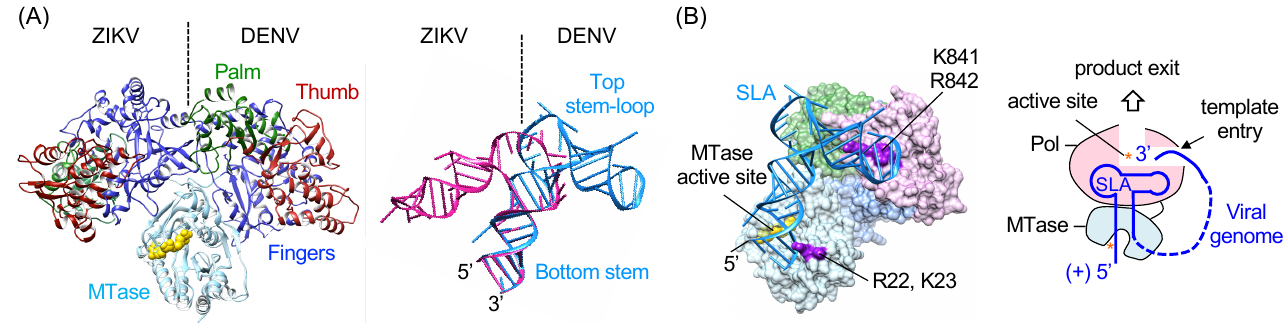
Figure 4. Model of the NS5-SLA complex. ( A ) Domain arrangements in flavivirus NS5 and stem-loop A (SLA). The structures of the flavivirus NS5 and SLA show different relative orientations of their domains. ZIKV and DENV NS5 structures are superposed by their MTase domains; domains are indicated only in DENV NS5 for clarity (left). The ZIKV and DENV SLA structures are superposed by their bottom stems, and the top stem-loop and bottom stem are indicated in DENV SLA (right). ( B ) Model of the NS5-SLA complex. The NS5-SLA complex is modeled based on the binding assays of mutant NS5 and previous biochemical assays. The schematic of SLA interaction with NS5 is shown on the right. The model suggests that flavivirus NS5 recognizes both the 5 (cid:48) end SLA and the 3 (cid:48) end of the viral genome, and thus can sequester intact viral RNAs on NS5 to ensure that viral polymerase copies complete viral